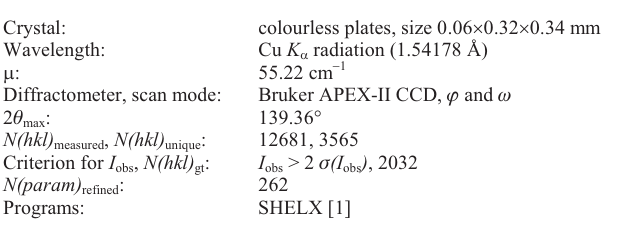
Table 1. Data collection and handling.